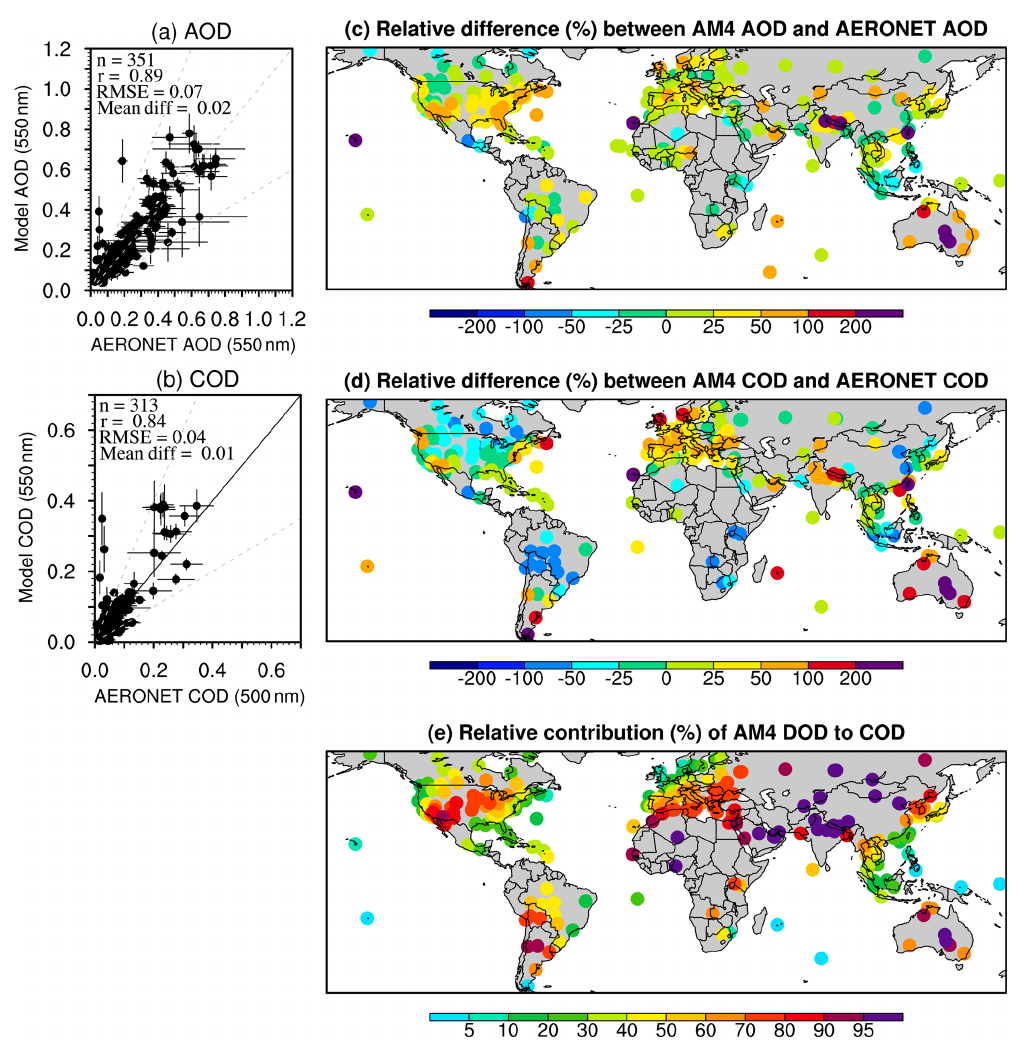
Figure 6. Same as Fig. 5 but for the V thresh 12mn